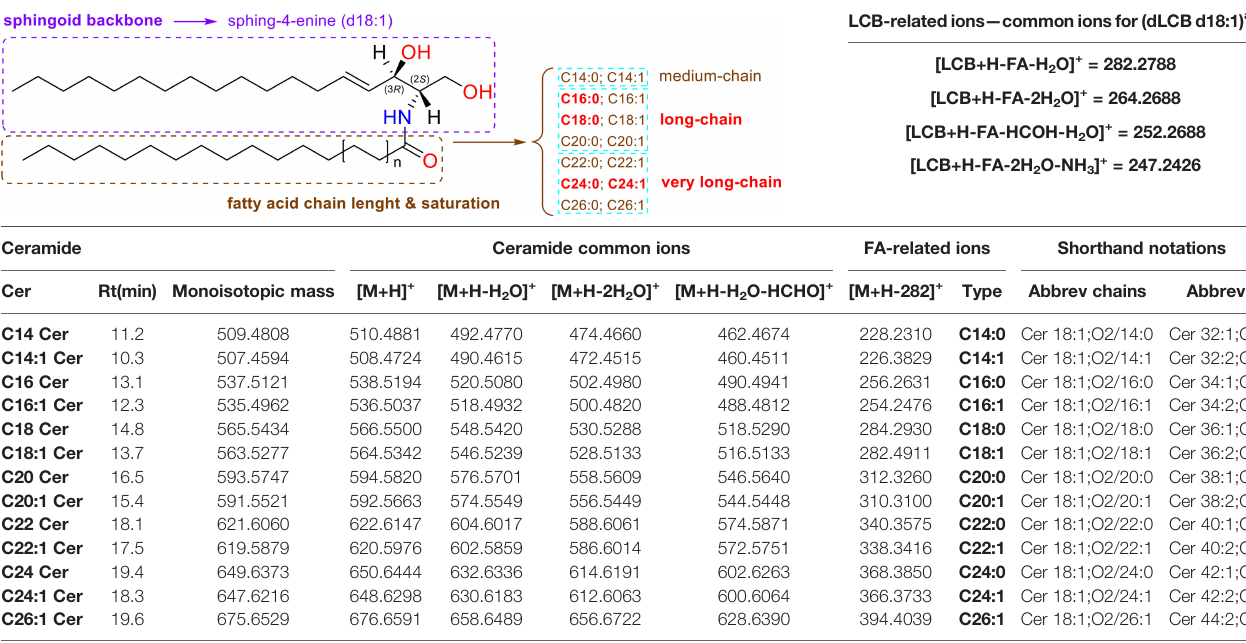
TABLE 1 | Complete characterization of ceramides in cells and exosomes from GCS phenotypes using UHPLC/ESI(+)-Q-TOF-MS/MS.